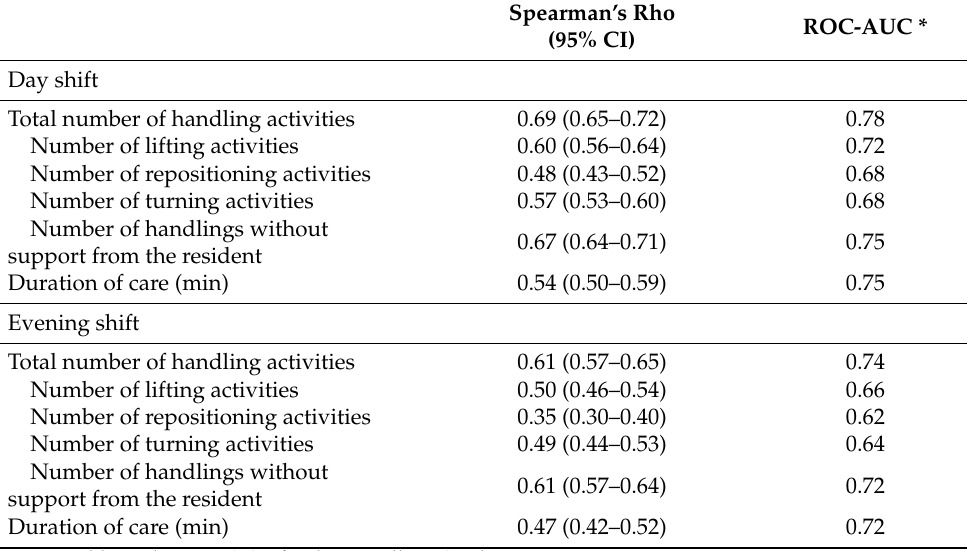
Table A2. Spearman’s rho correlation coefficient between the resident need for assistance scale and observed outcomes, and area under the receiver operating characteristics curve (ROC-AUC) values for day and evening